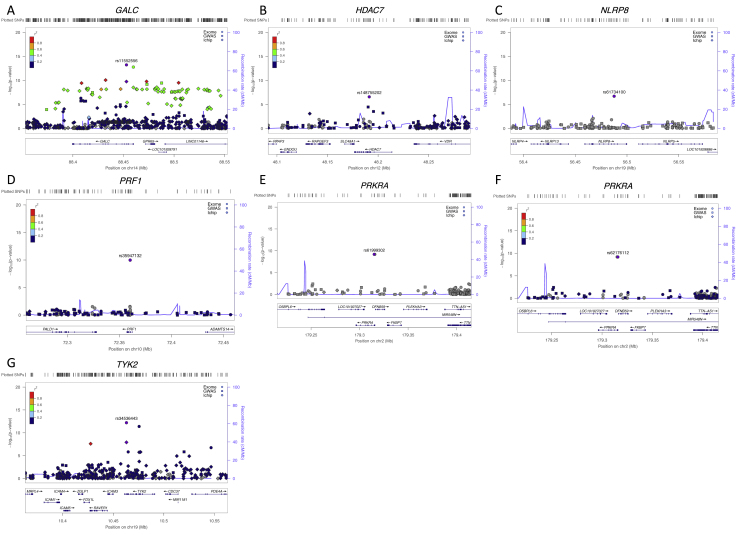
Patterns of Association for Common and Rare Variants in Seven Genome-wide Significant Loci, Related to Figure 1Plots are centered on the seven variants reported in Figure 1 and Table 1. Each show LD and association signal of low frequency variants (circles, this study), and common variants from our most recent GWAS (squares, 14,802 MS cases and 26,703 controls; International Multiple Sclerosis Genetics Consortium et al., 2017) and the ImmunoChip meta-analysis (diamonds; Beecham et al., 2013). For GALC and TYK2, our most associated variants, rs11552556 and rs34536443 respectively, capture the common variant signals we have previously reported (panels A and G). For the remaining loci, our most associated variants show no LD to other variants, with no evidence of association in our common variant studies (panels B-F).